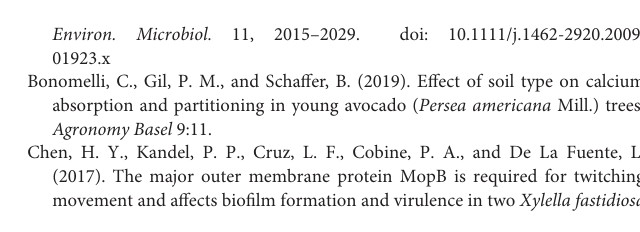
FIGURE S1 | Growth curve of wild type with different modified TY and L3 medium. Values are shown as the means and standard deviations from at least three independent experiments. FIGURE S2 | Growth curve of wild type with different concentrations of calcium from 0 to 900 mM. Values are shown as the means and standard deviations from at least three independent experiments. FIGURE S3 | Biofilm biomass of wild type with different concentrations of magnesium instead of calcium after 6, 9, and 12 h. Values are shown as the means and standard deviations from at least three independent experiments. FIGURE S4 | Biofilm formation of wild type with different washing treatment. (A) Before testing the role of calcium on biofilm formation of A. caulinodans , bacterial cells cultured with TY medium were washed three times with TY no calcium medium. (B) Bacterial cells were cultured with TY medium without calcium, and then they were used to test the role of calcium on biofilm formation directly. Images at the top means the representative results of them. Values are shown as the means and standard deviations from at least three independent